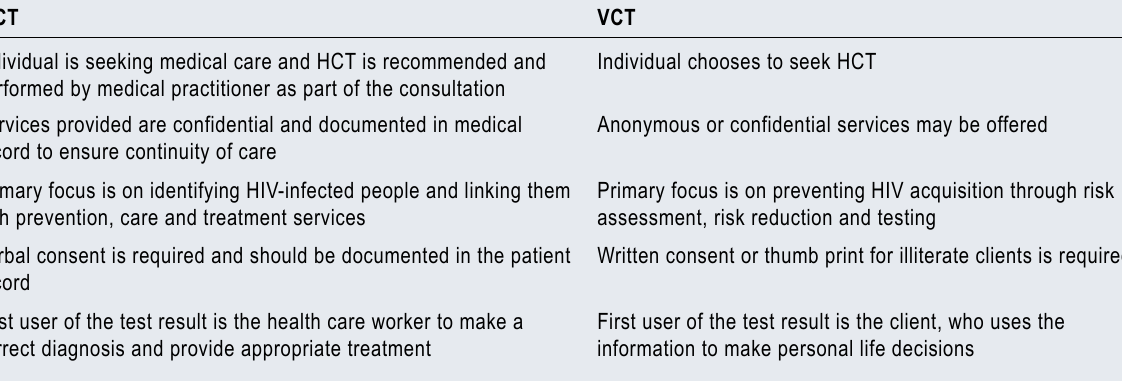
TABLE I. DIFFERENCES BETWEEN PICT AND